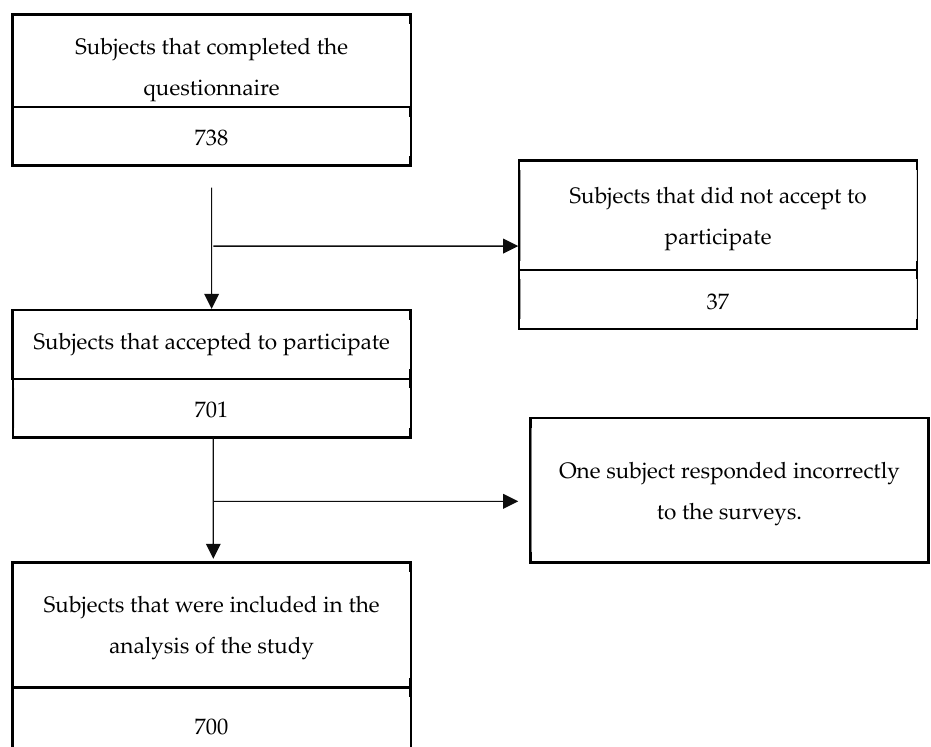
Figure 2. Flowchart of the selection of study participants.